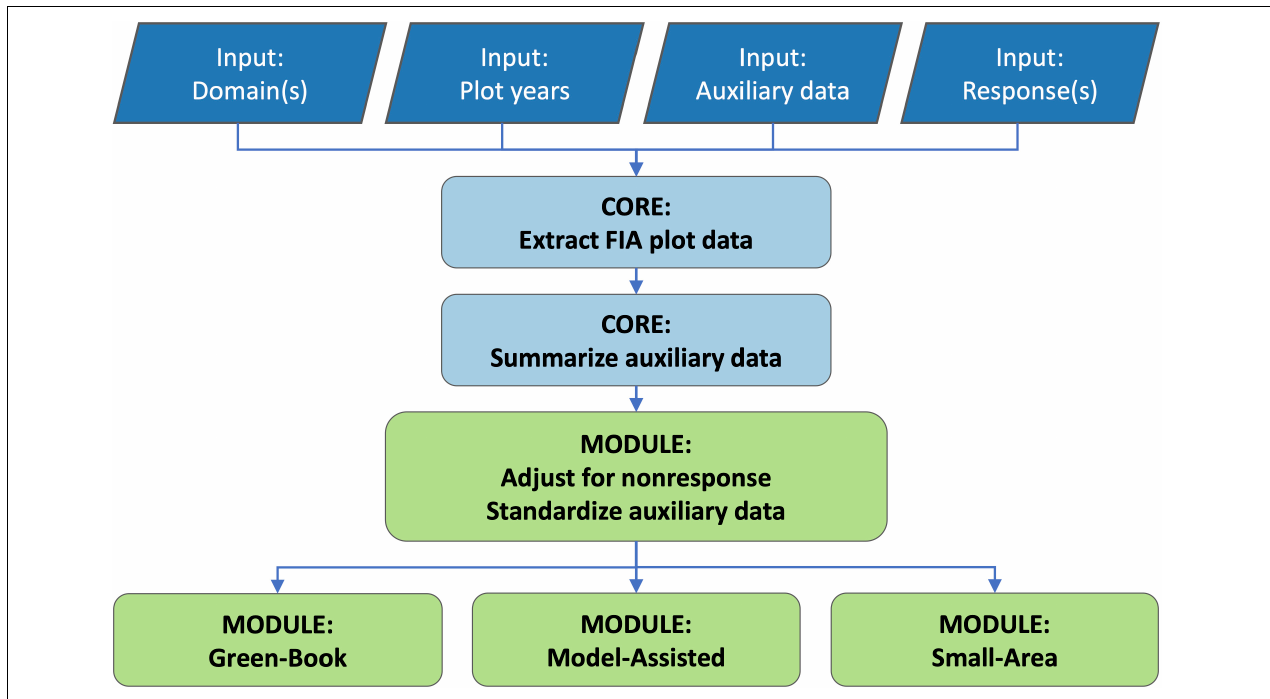
FIGURE 1 | Flowchart of FIESTA functions used for dashboard